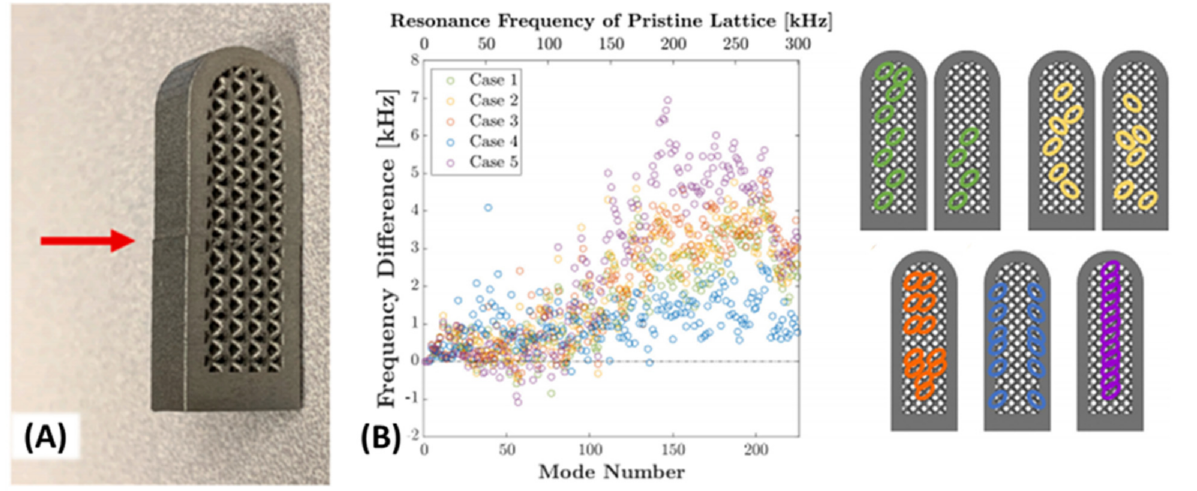
Figure 18. ( A ) Additive manufacturing printed sample with layer off-set flaw intentionally made by stoppage. ( B ) Numerically simulated eigenfrequency shifting of the object with different types and numbers of small intentionally introduced